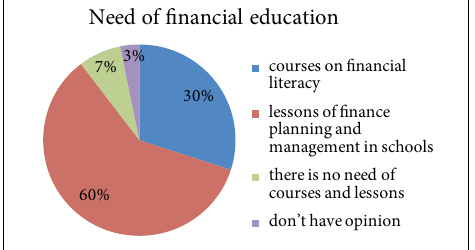
Fig. 10. Respondents’ opinion towards the need of financial education (authorial computation, according to the survey data)